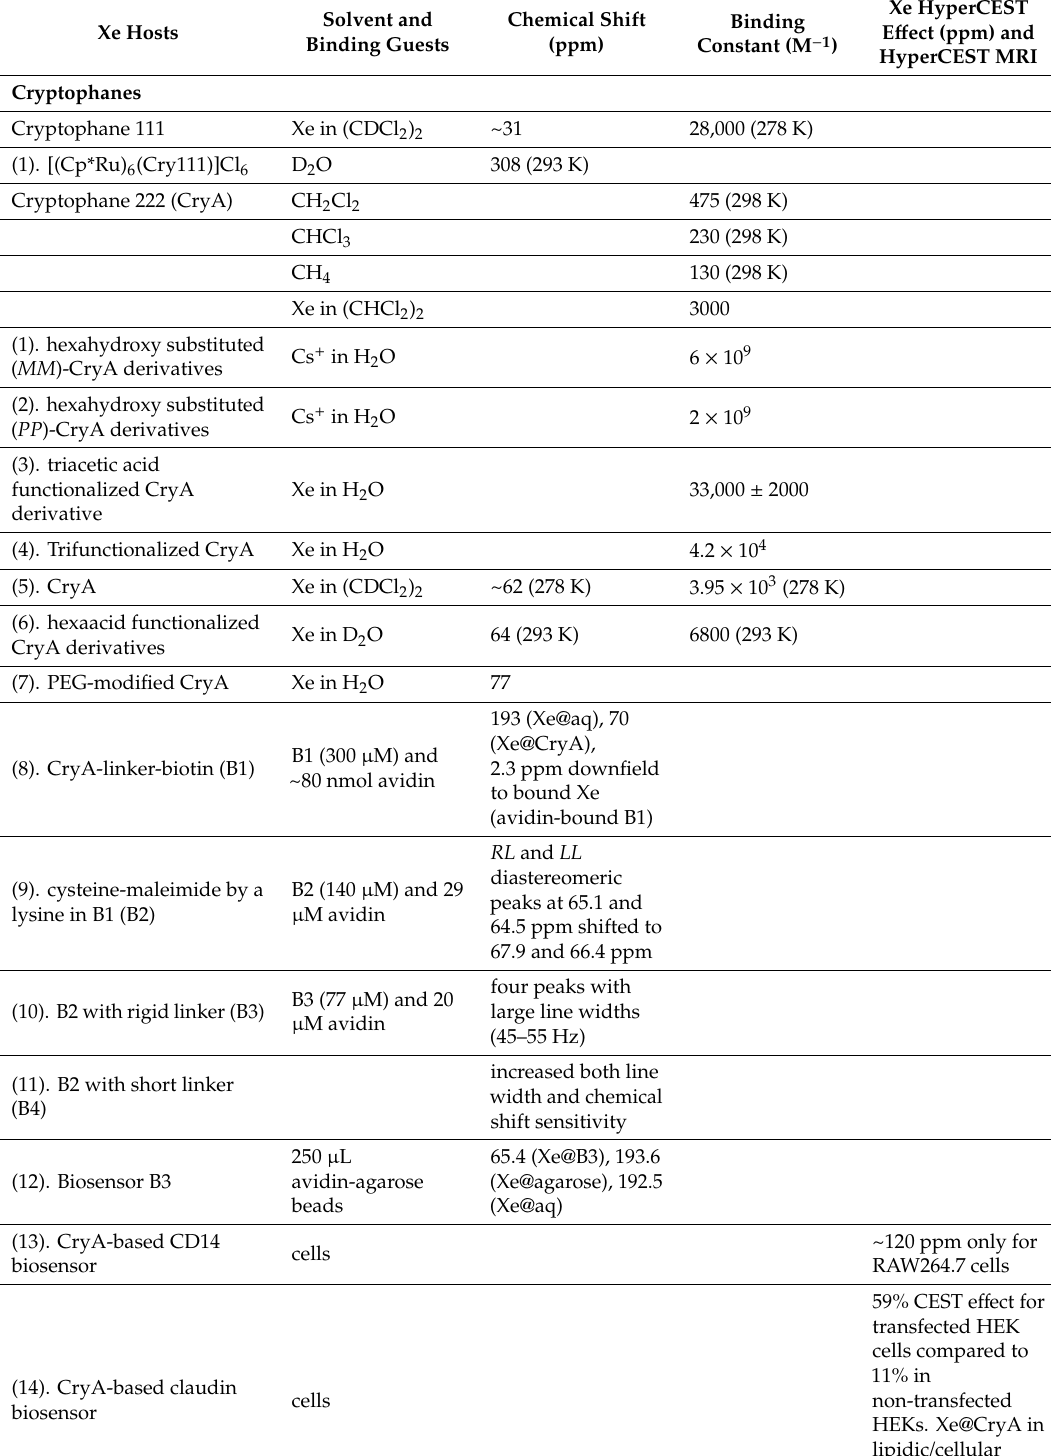
Table 2. Di ff erent important details pertaining to various 129 Xe